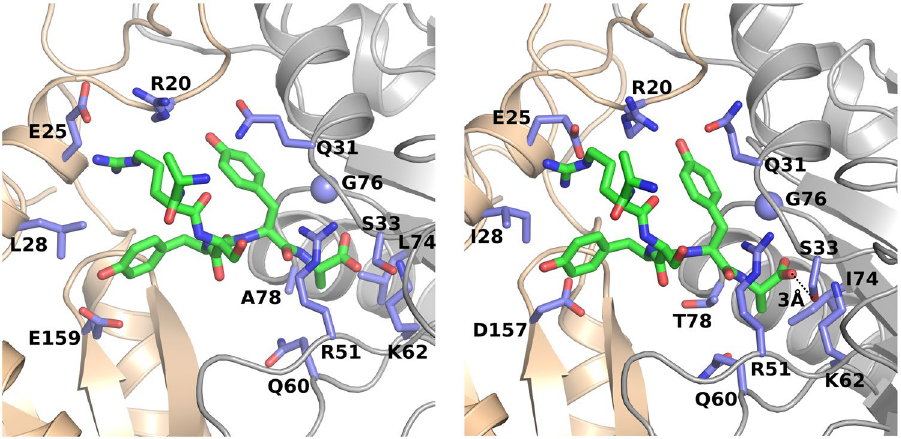
Figure 5. Comparison of Blm-pep interaction with yeast and human proteasome. Left – structure of yeast 20S proteasome ( α 5 and α 6 are colored beige and gray, respectively) in complex with Blm-pep (green), determined in this study (5NIF). Interacting residues within the proteasome are highlighted blue. Right – modeled interaction of Blm-pep with human 20S proteasome (model based on 4R3O; orientation and colour coding same as in the left panel). The hydrogen bond distinguishing the interactions of Blm-pep with yeast and human 20S is shown (see